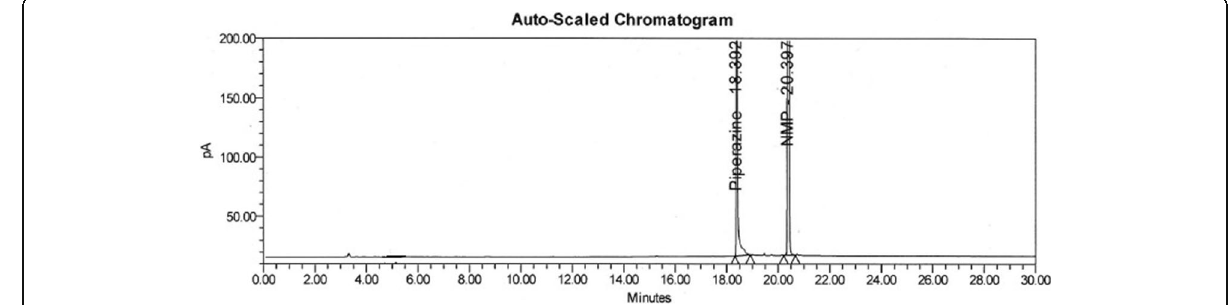
Fig. 2 Typical Chromatogram of